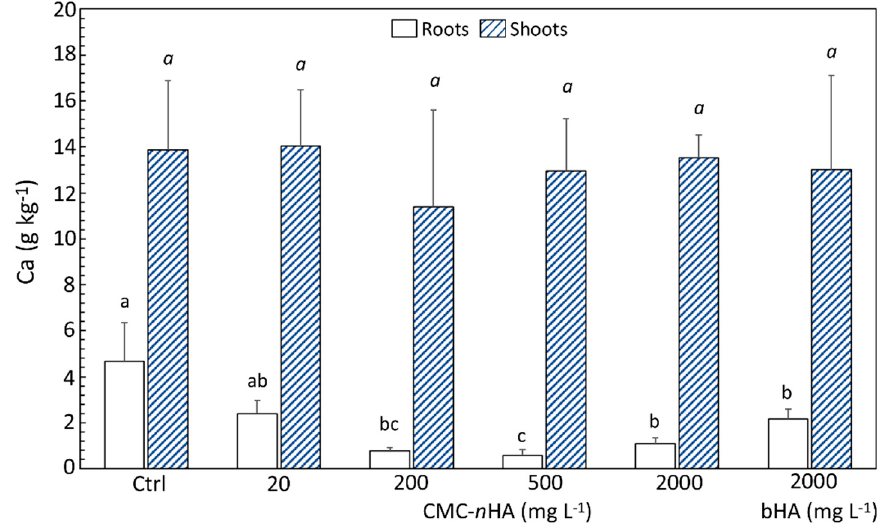
Figure 8. Ca concentration (g kg − 1 ) in the roots and shoots of S. lycopersicum seedlings. Bars represent the mean standard error. Different letters indicate statistically significant differences between treatments (MWW test, p ≤ 0.05).